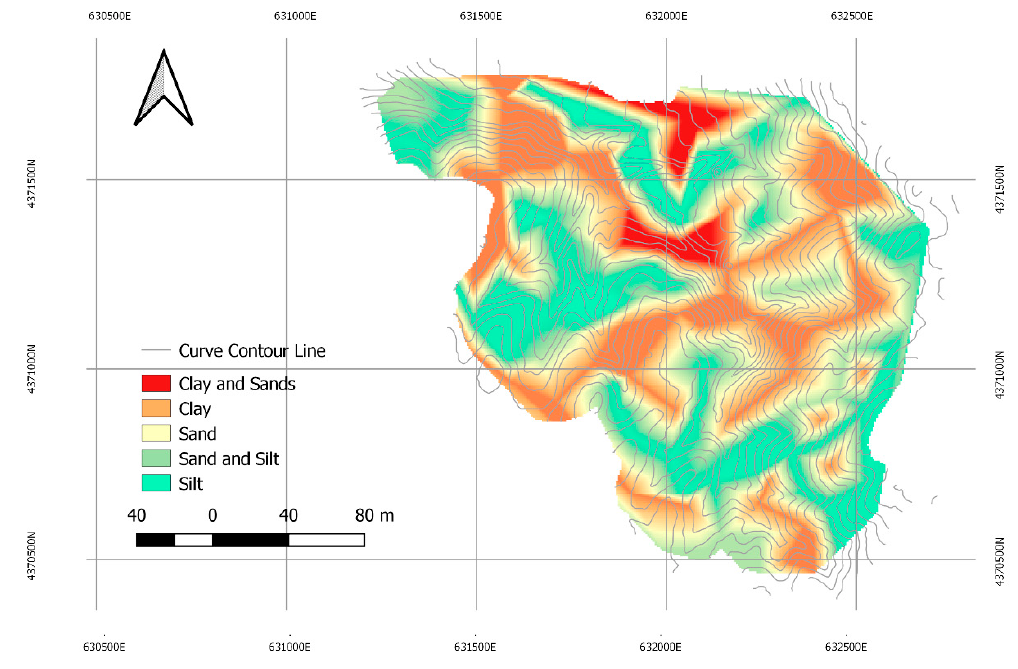
Figure 4. Soil map of the Bonis catchment.